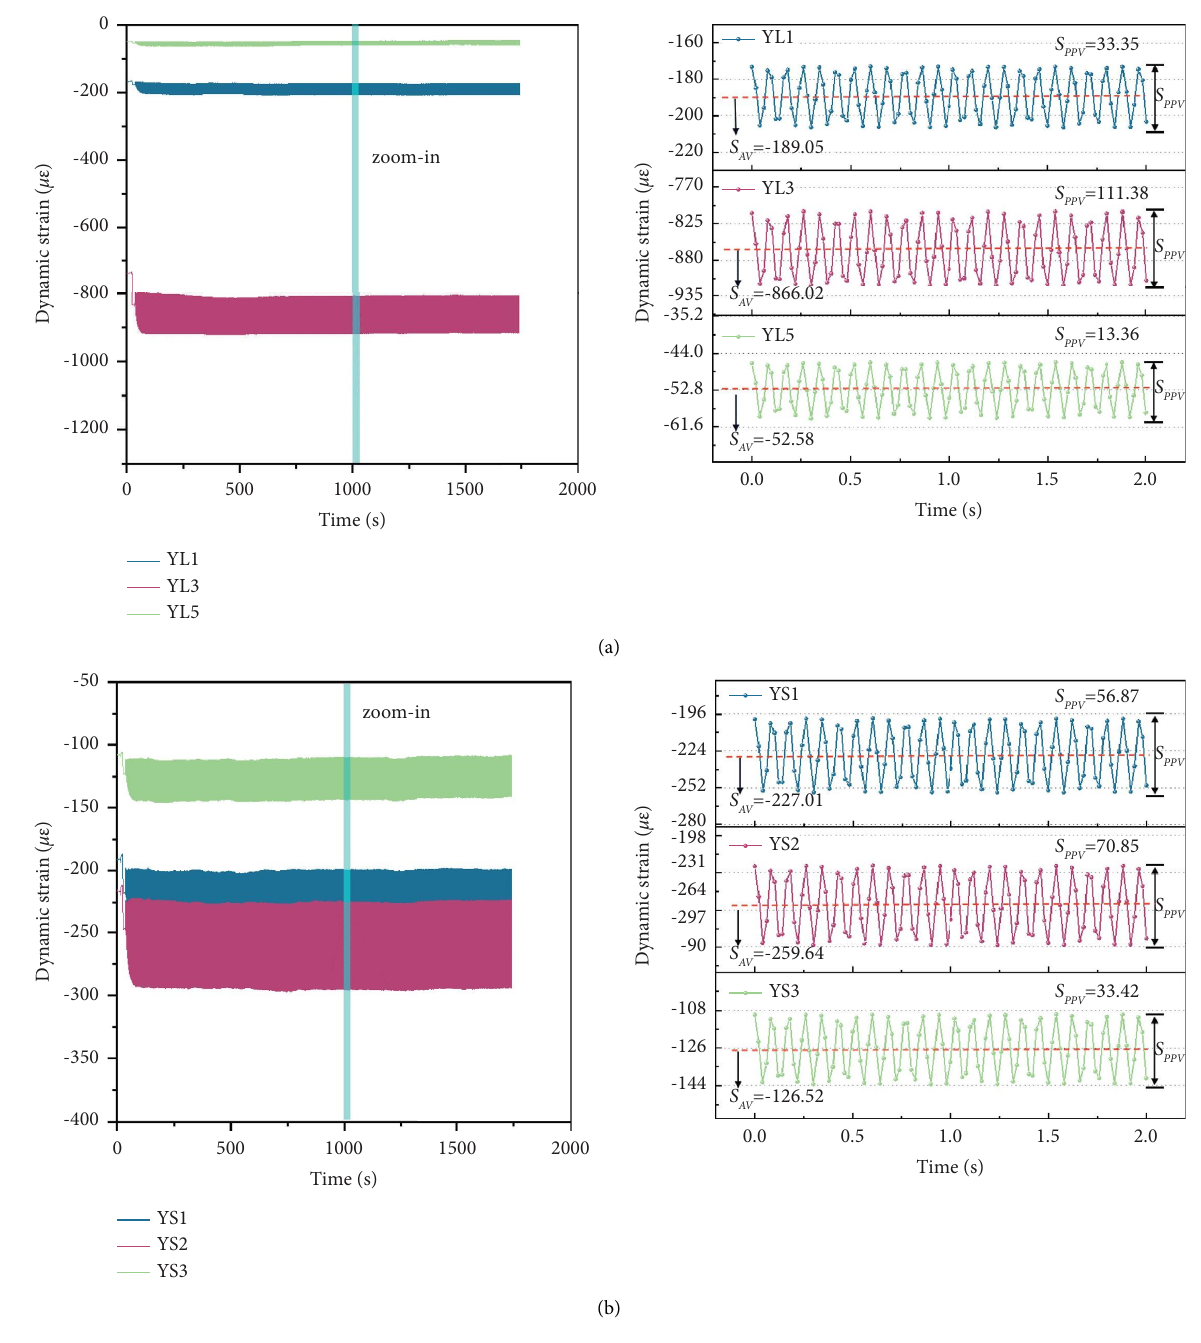
Figure 9: Te time-history response curve of dynamic strain. (a) Time history curve of dynamic strain of the long pile. (b) Time history curve of dynamic strain of the short